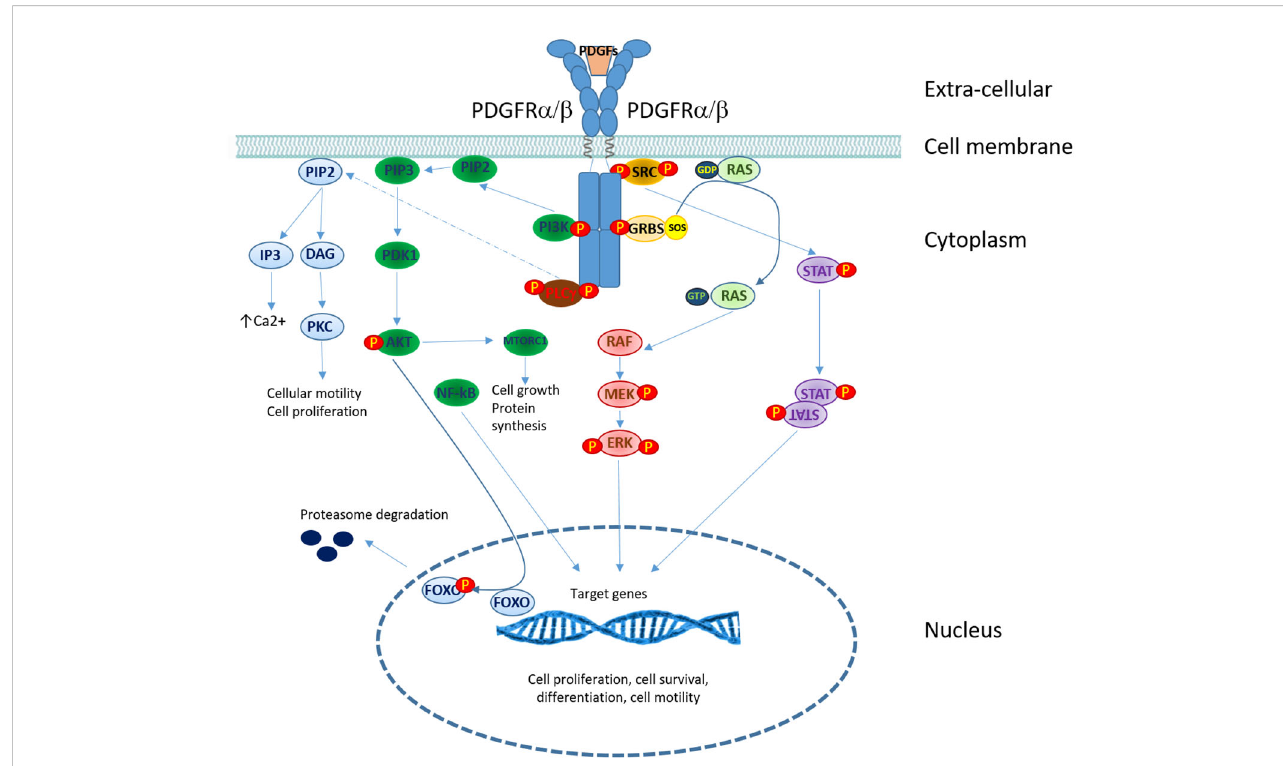
FIGURE 3 PDGFRs signaling in T-cell lymphomas. Overview of signaling pathways downstream of PDGF receptors. PDGF binding induces receptor dimerization and trans-phosphorylation. The recruitment of signaling and adaptor molecules to the phosphorylated receptor triggers several signaling cascades: phospholipase C g (PLC g ), phosphatidylinositol-3-kinase (PI3K), mitogen-activated protein (MAP) kinases and signal transducers and activators of transcription (STATs). (P, phosphorylation